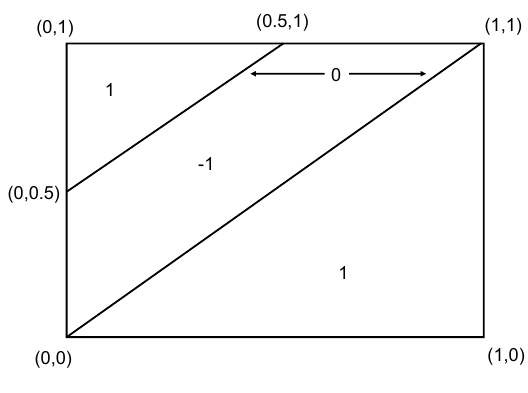
Figure 1. Example 2: The payoff functions of